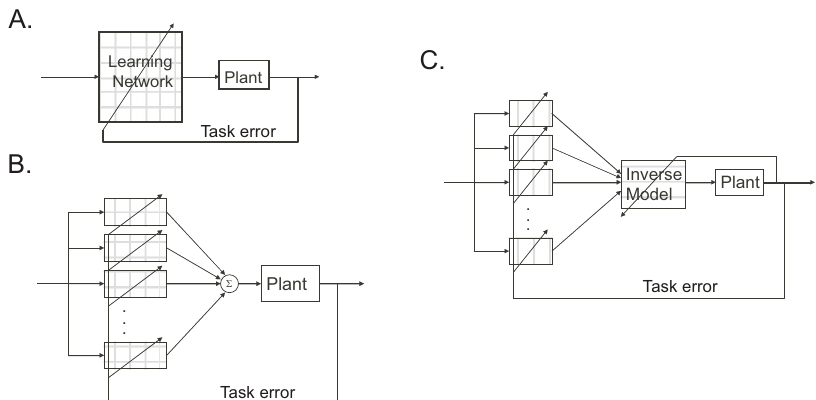
Figure 1. Different neural network models. A . Structure (1) is a single learning network that adapts to both changes in skill and environment. The same system learns based on errors in the observed task. B . Structure (2) is a motor program model. Learning is performed by separate network for each task based again only on observed error. C . Structure (3) is a two system-learning model. This model splits into two groups of systems, where there is a separate system for each task, learning based on observed error, but a single inverse model for control of the environment, learning based on prediction